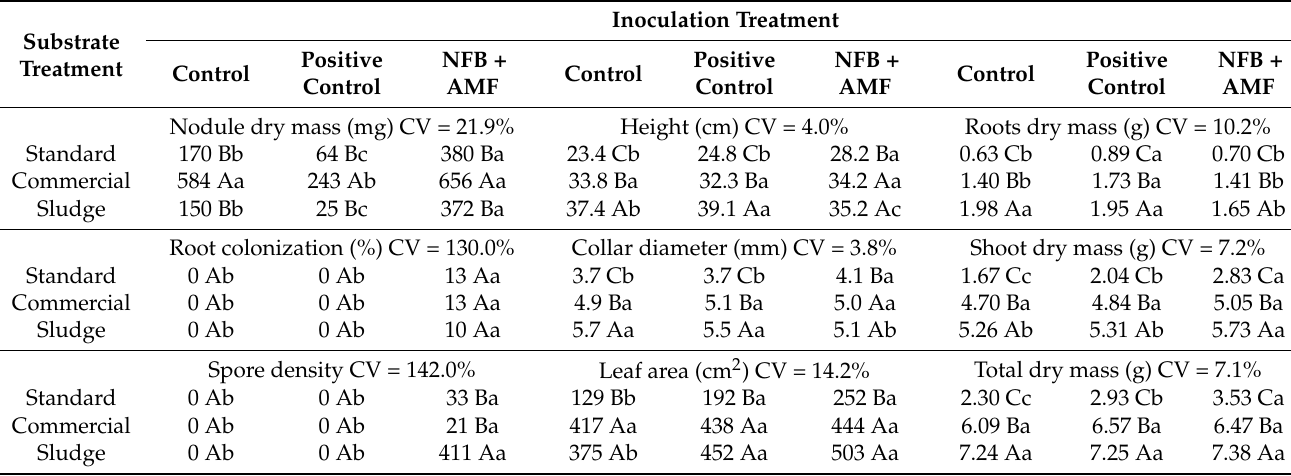
Table 2. Morphological parameters before planting of Samanea saman seedlings produced with different treatments of substrate and